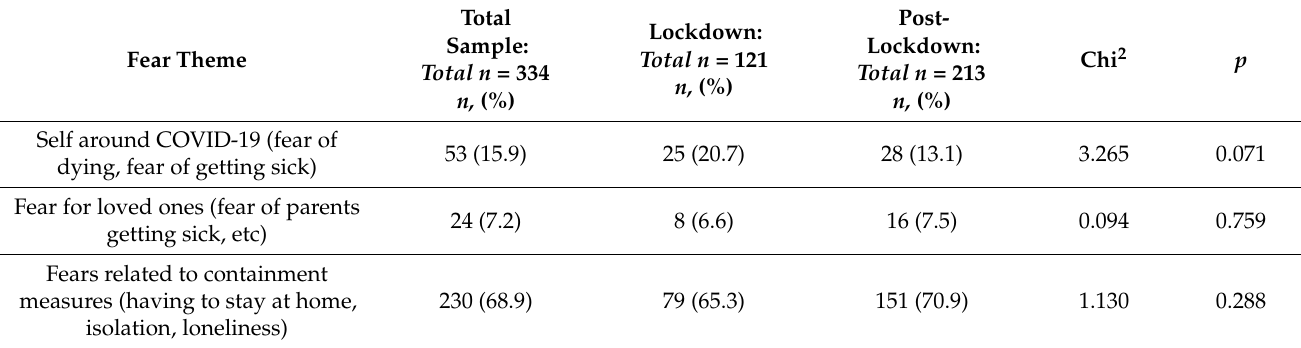
Table 2. Differences in COVID-19 related fears according to admission periods (lockdown vs. post-lockdown). For a general comparison of the socio-demographic characteristics between the lockdown/post-lockdown groups, please see Table 1 in [8].